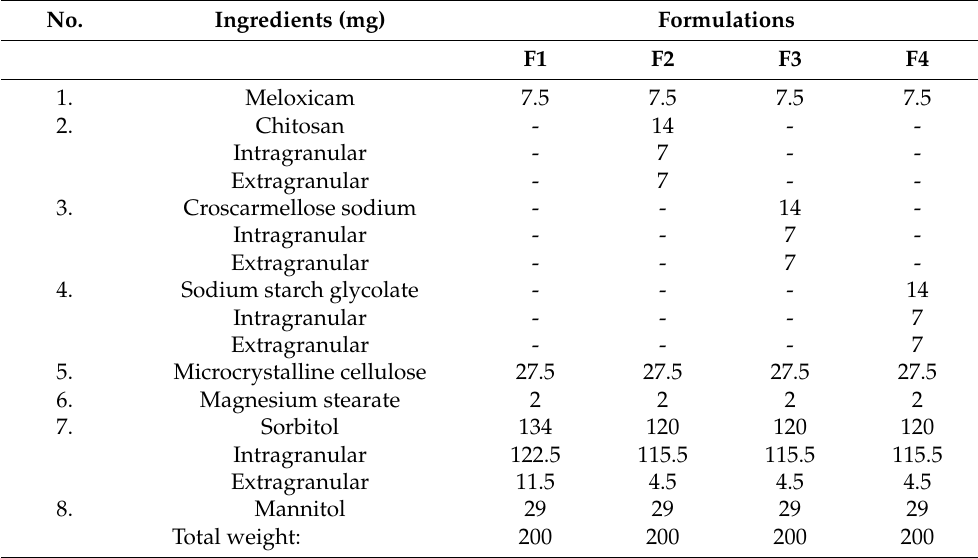
Table 1. Composition of fast disintegrating tablets of Meloxicam prepared by wet granulation method.